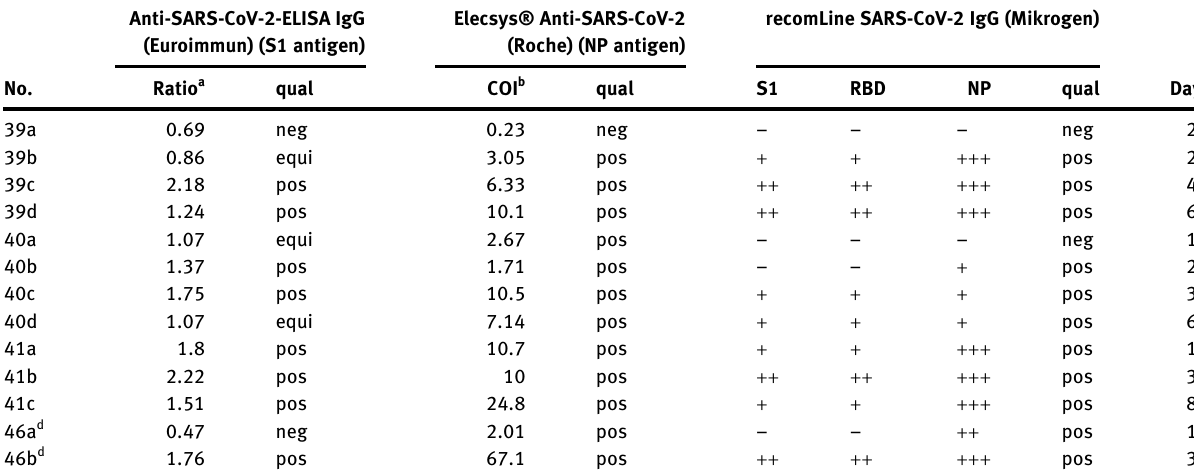
Table  : Results of immunoassays and recomLine assay in PCR-con fi rmed COVID-  patients with follow-up serum samples. Anti-SARS-CoV-  -ELISA